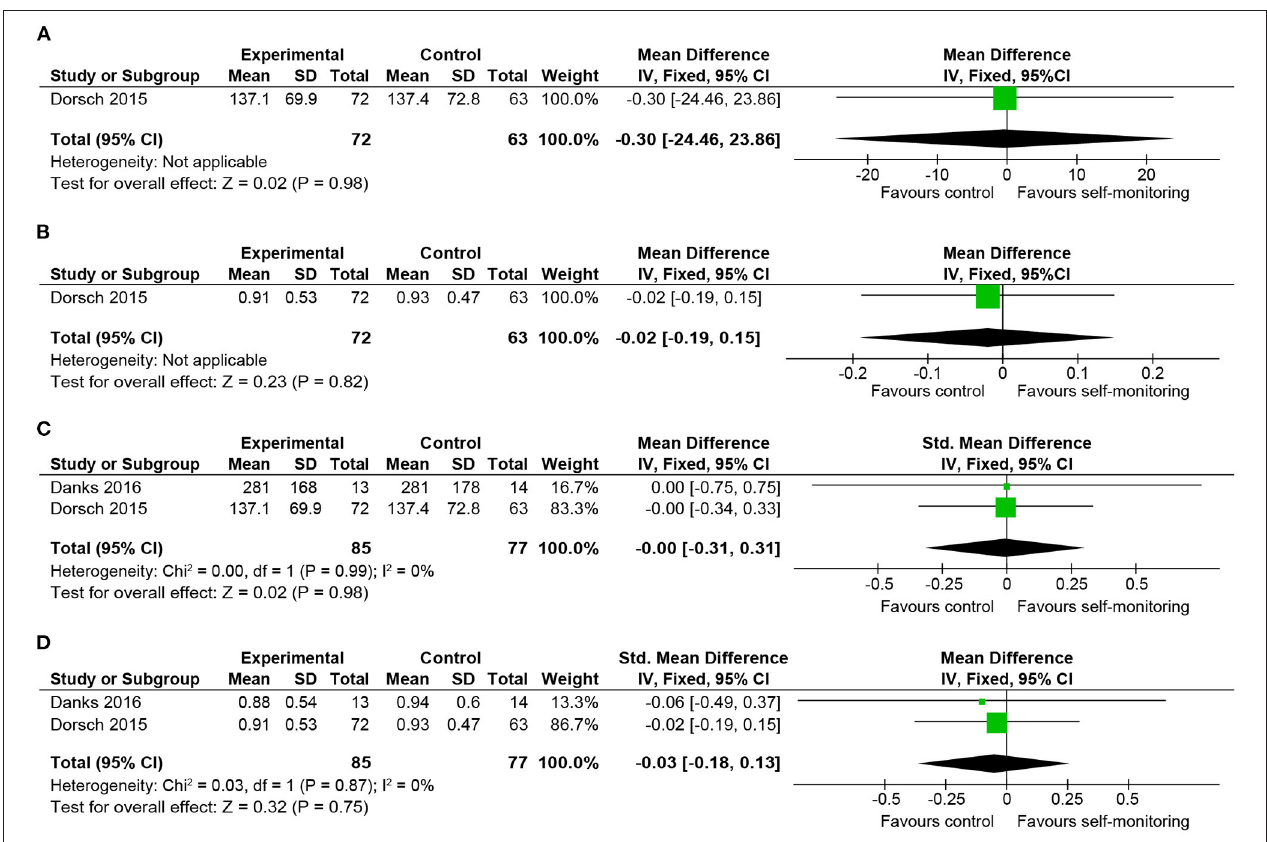
FIGURE 4 | Comparison of walking ability in patients with stroke. (A) Walking endurance (3-min walking distance, m) post-intervention. (B) Gait speed (maximal, m/s) post-intervention. (C) Walking endurance (timed walking distance, m) post-intervention including a study at high risk of bias. (D) Gait speed (maximal, m/s) post-intervention including a study at high risk of bias. SD, standard deviation; IV, inverse variance method; CI, confidence interval.